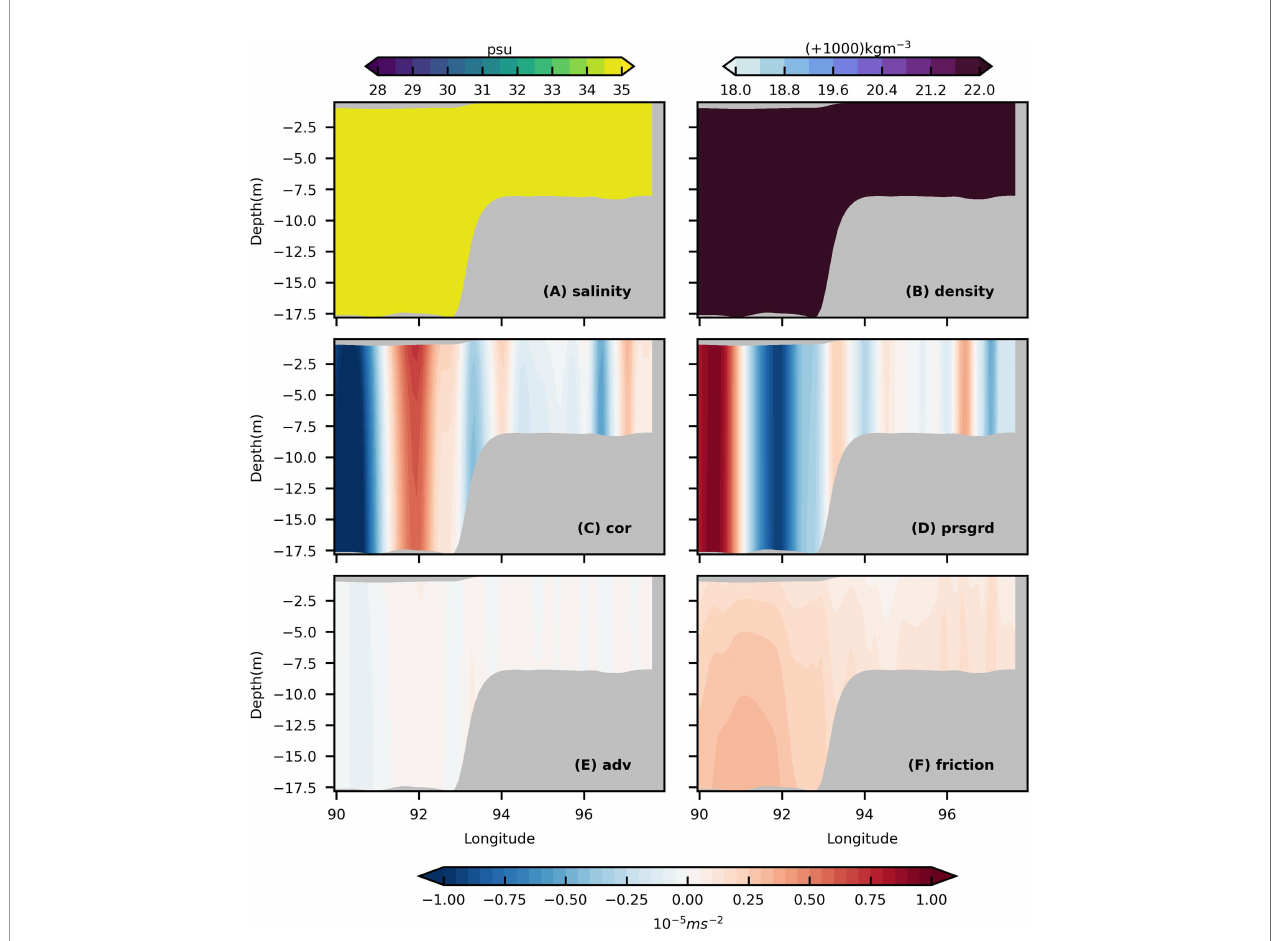
FIGURE 13 | Distribution of (A) salinity, (B) density and (C – F) u-momentum terms from the sixth year of experiment SpinFullW for month of August. The distribution presented is across